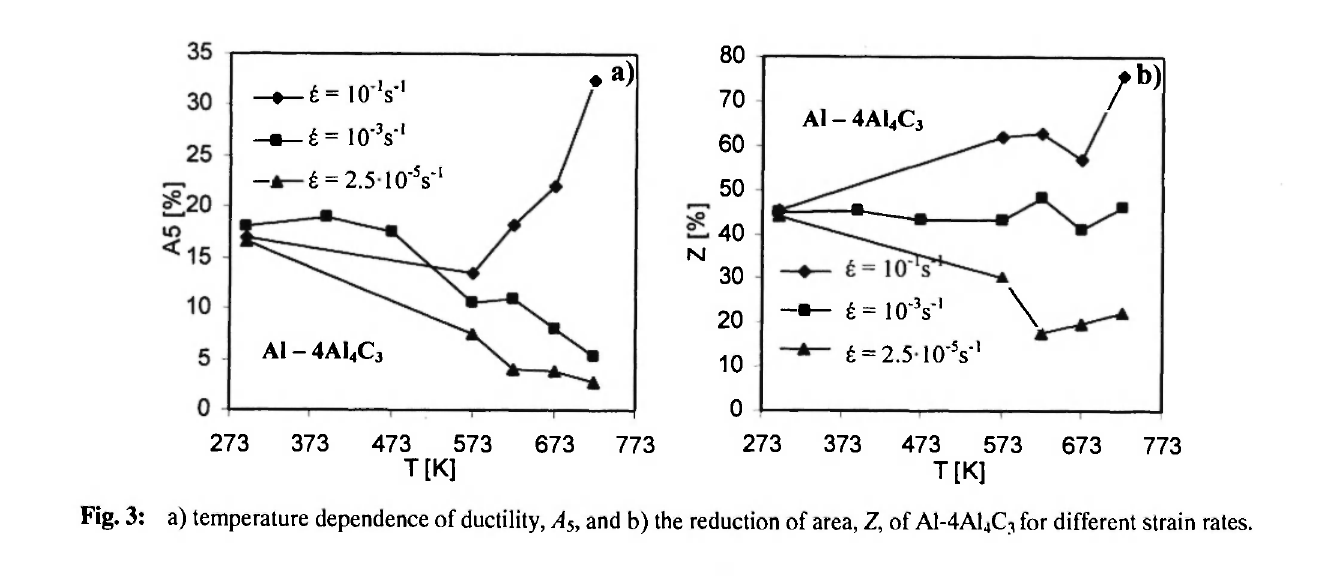
a) temperature dependence of ductility, A s , and b) the reduction of area, Z, of A1-4A1 4 C 3 for different strain rates.